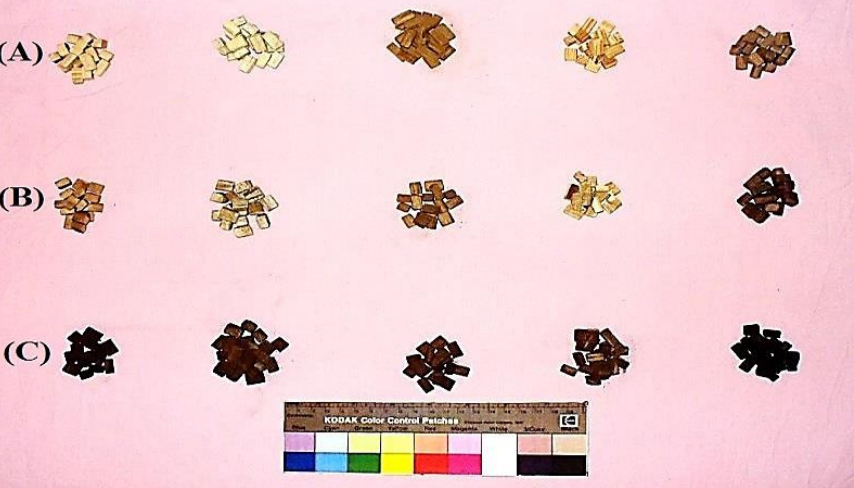
Figure 1. Groups of five age-accelerated wood species: ( A ) control, ( B ) heated and ( C ) rusted.